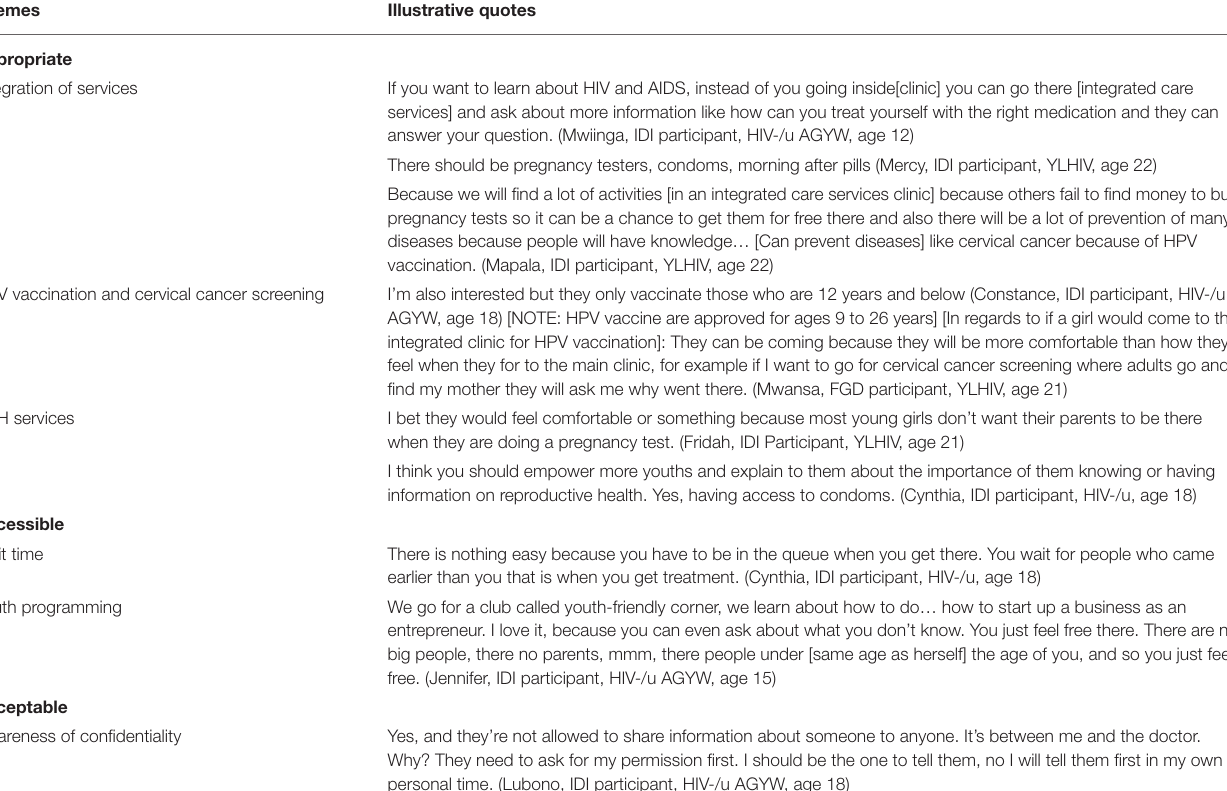
TABLE 3 | Illustrative quotes across selected key attributes of youth-friendly service provision. Themes